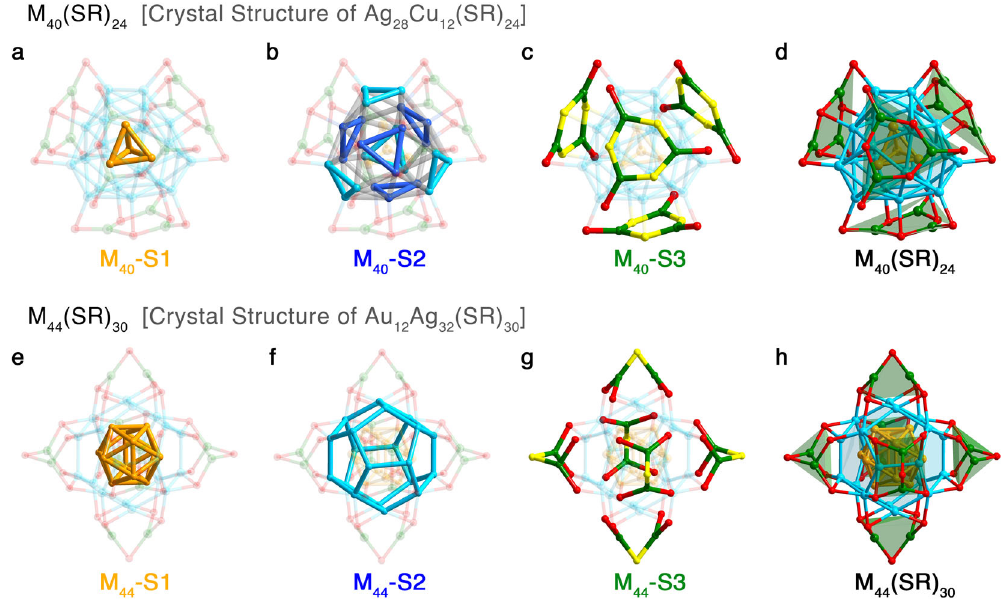
Fig. 1 Structure anatomies of M 40 (SPhCl 2 ) 24 and M 44 (SPhCl 2 ) 30 (M = Au/Ag/Cu). a – d Structure anatomy of M 40 (SPhCl 2 ) 24 : a M 40 -S1: the tetrahedral M 4 kernel; b M 40 -S2: the M 24 shell; c M 40 -S3: the Cu 12 (SR) 24 surface; and d The overall structure of M 40 (SPhCl 2 ) 24 . e – h Structure anatomy of M 44 (SPhCl 2 ) 30 . e M 44 -S1: the hollow icosahedral M 12 kernel; f M 44 -S2: the M 20 shell; g M 40 -S3: the M 12 (SR) 30 surface; and h The overall structure of M 44 (SPhCl 2 ) 30 . Color labels: orange/light blue/blue/green, Ag or Cu atoms at different positions; red, S. All C and H atoms are omitted for clarity.